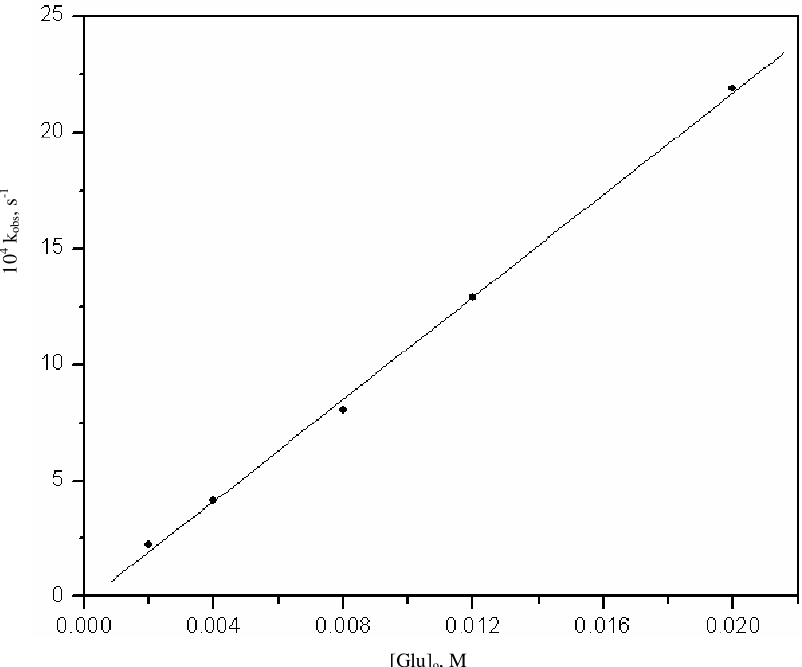
Figure 1. Direct plot of k versus [amino acid] for the oxidation of glutamic acid with obs